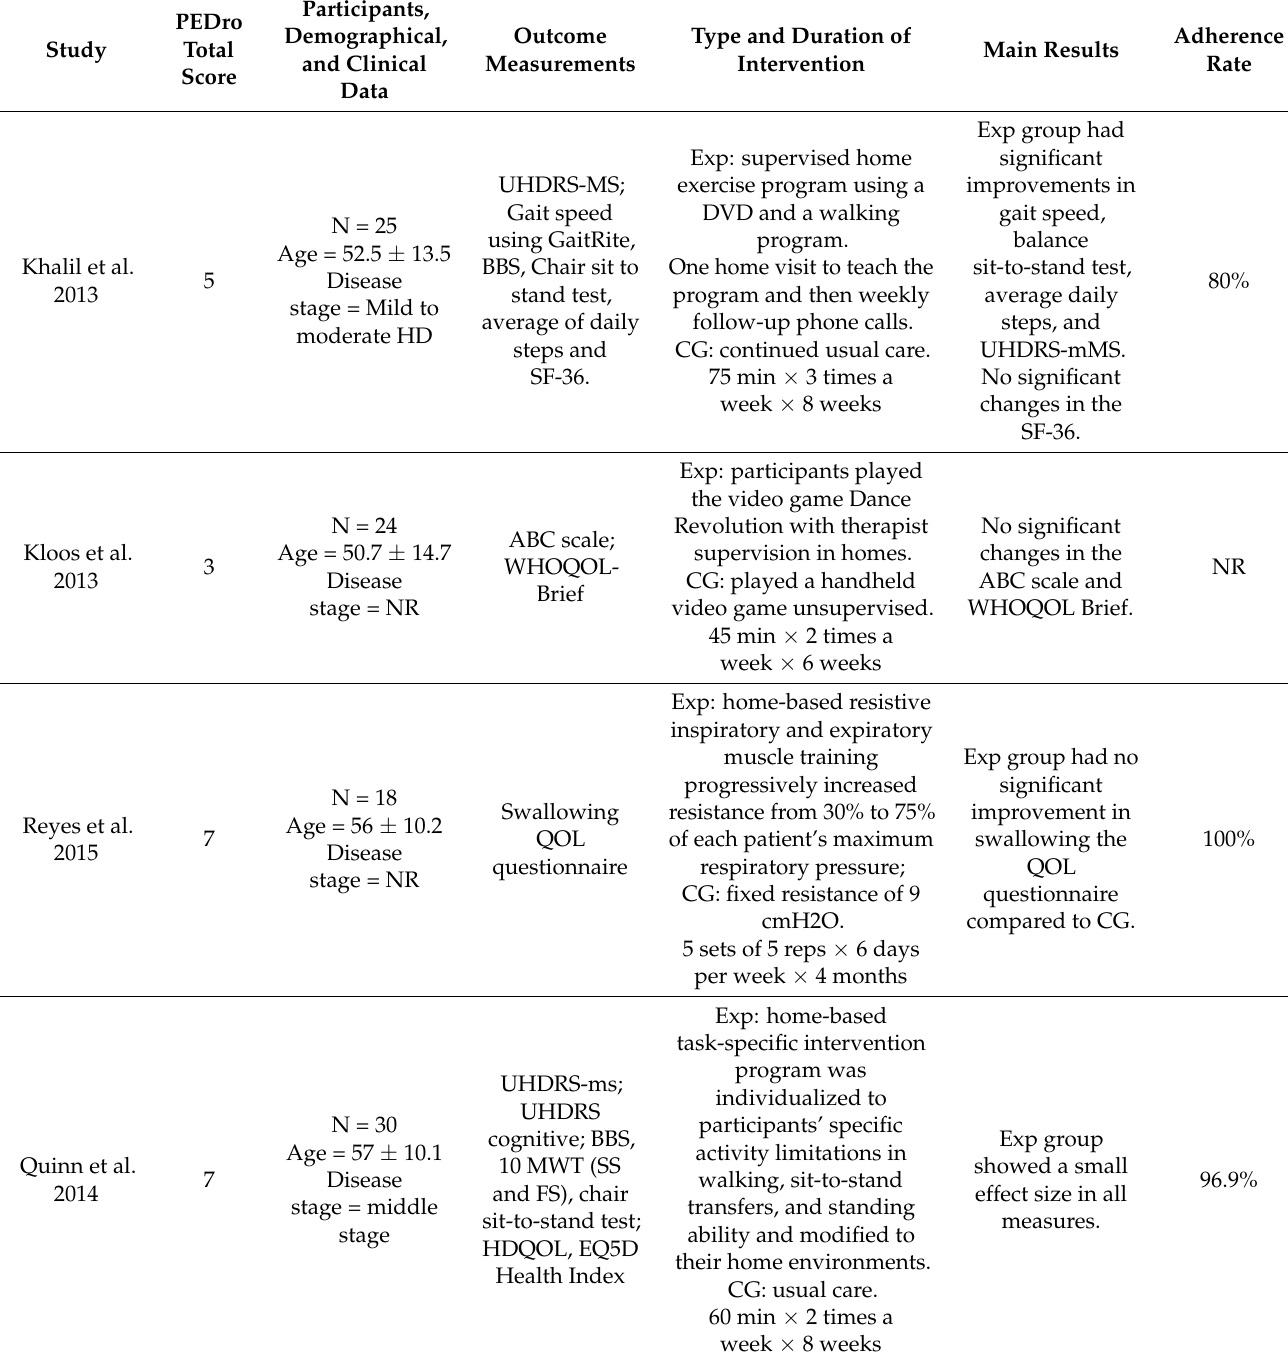
Table 1. The summary and characteristics of the included